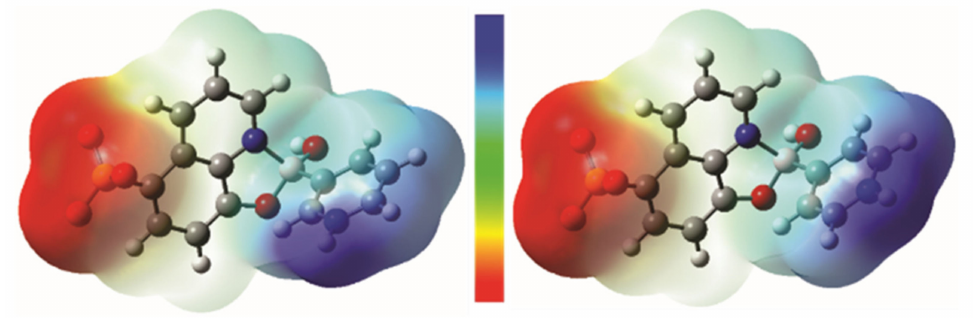
Figure 8. Electrostatic potential mapped on the isodensity surface of the molecular structure of 1 ( left ) and 2 ( right ). The color code thresholds are red − 0.1 and blue +0.1 (calculated at the DFT level M06/6-31G